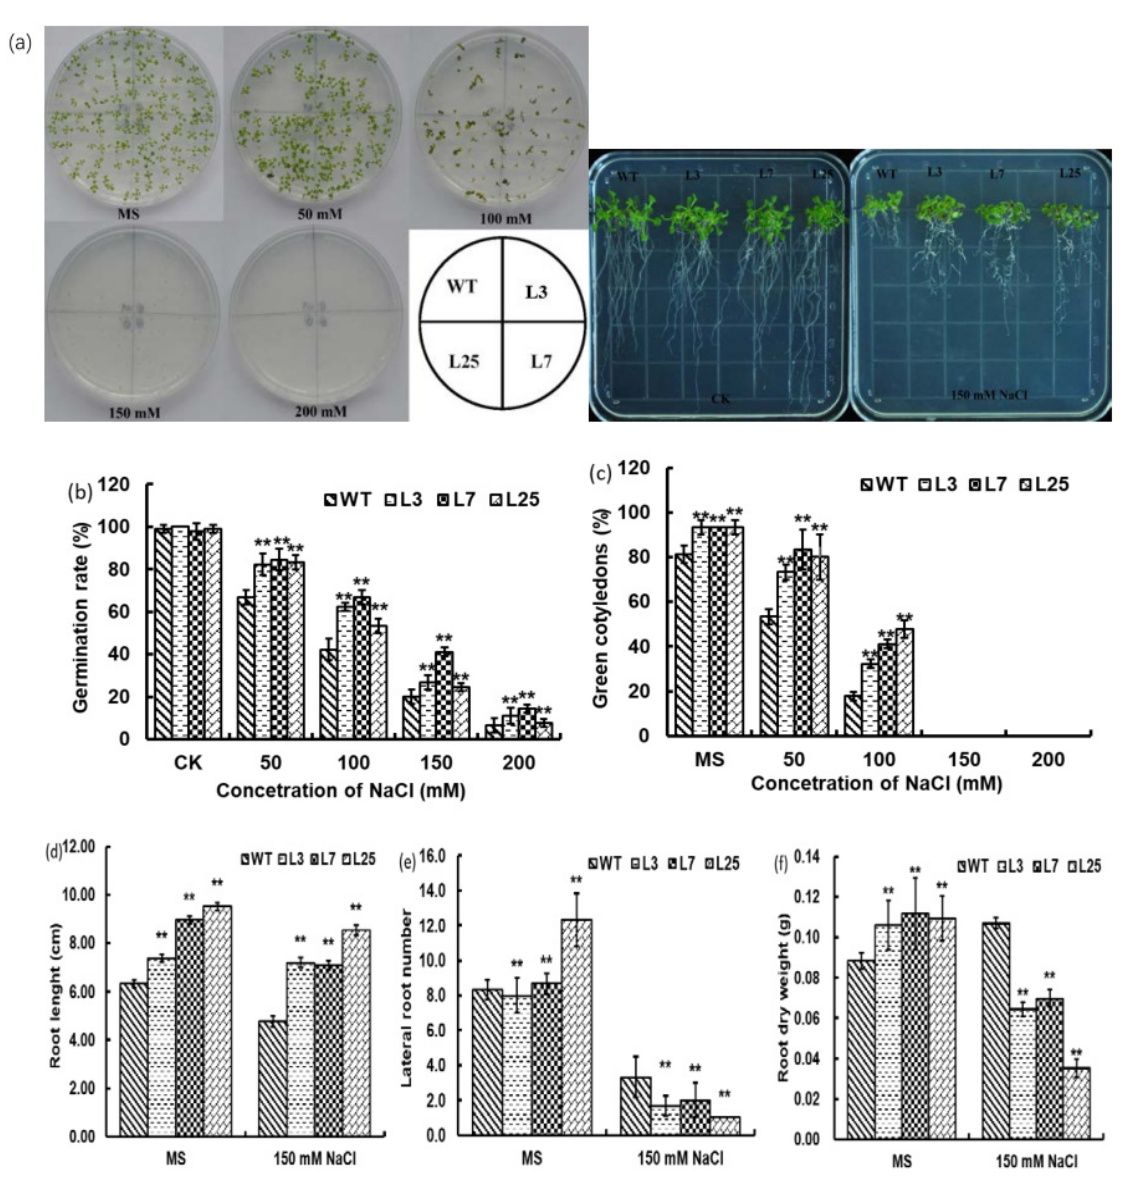
Figure 5. The morphological characteristics of transgenic Arabidopsis thaliana were different under the NaCl treatments (CK, 50, 100, 150 and 200 mM). ** indicate a significant difference at the 1% level. ( a ) The germination and root morphology of plants treated with NaCl were studied. ( b ) Germination rate (%). ( c ) Green cotyledons (%). ( d ) The root length was measured on the 20th day. ( e ) The number of lateral roots was measured on the 20th day. ( f ) Root dry weight was measured on the 20th day ( g ). Root length, number of lateral roots and root dry weight of 35S::ZmHDZIV13 and WT Arabidopsis seedlings under NaCl and mannitol stresses were measured or counted. Under NaCl and mannitol stresses, the number of lateral roots from ZmHDZIV13 was higher than that of WT (Figures 5e and 6e) and the transgenic 35S::ZmHDZIV13 seedlings showed strong osmotic resistance. With the addition of 150 mM NaCl, the average root